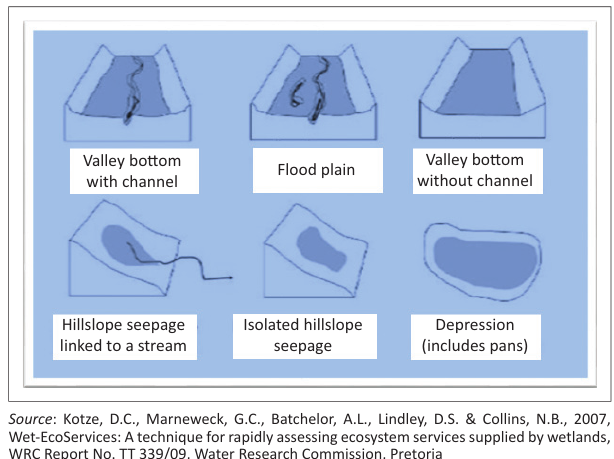
FIGURE 2: The hydro-geomorphic classification of